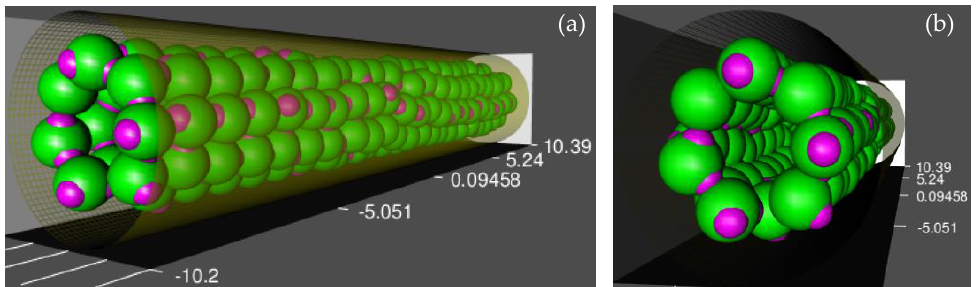
Figure 7. Snapshot showing a monolayer formed on a 0.95 nm pore at 25 °C with strengthened wall-water interaction: ( a ) side view and ( b ) front view. Each green ball with two attached magenta balls represents a water molecule.